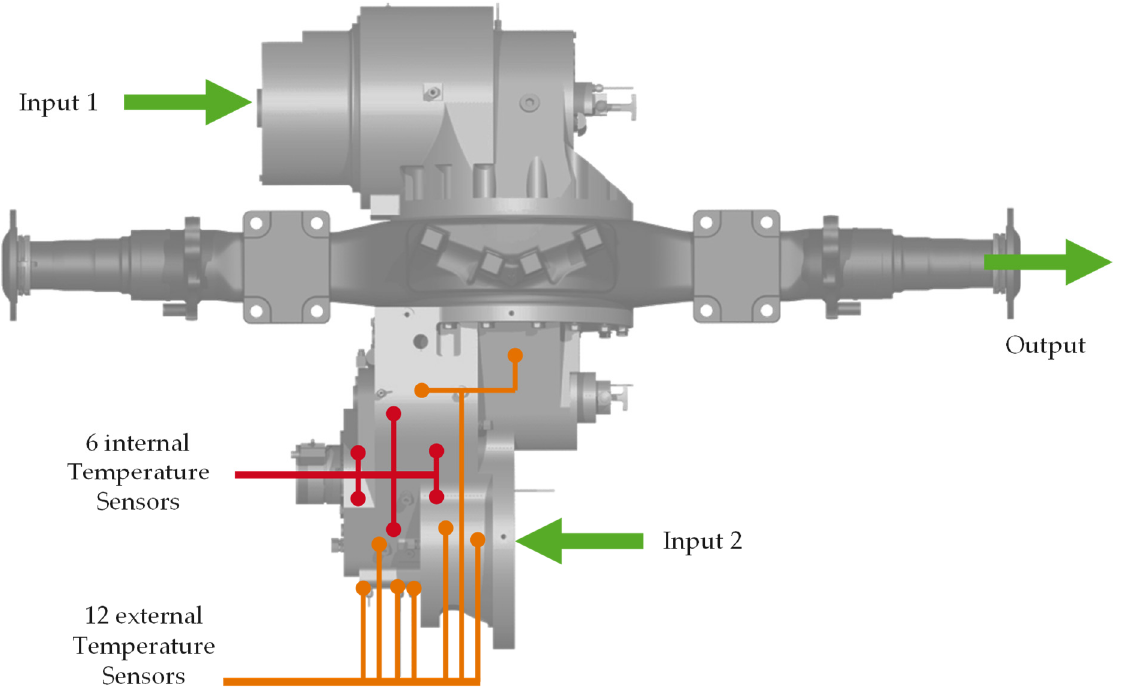
Figure 8. Measurement setup of the prototype for measuring the mechanical efficiency as well as the temperatures of 12 stationary and 6 rotating gearbox components.